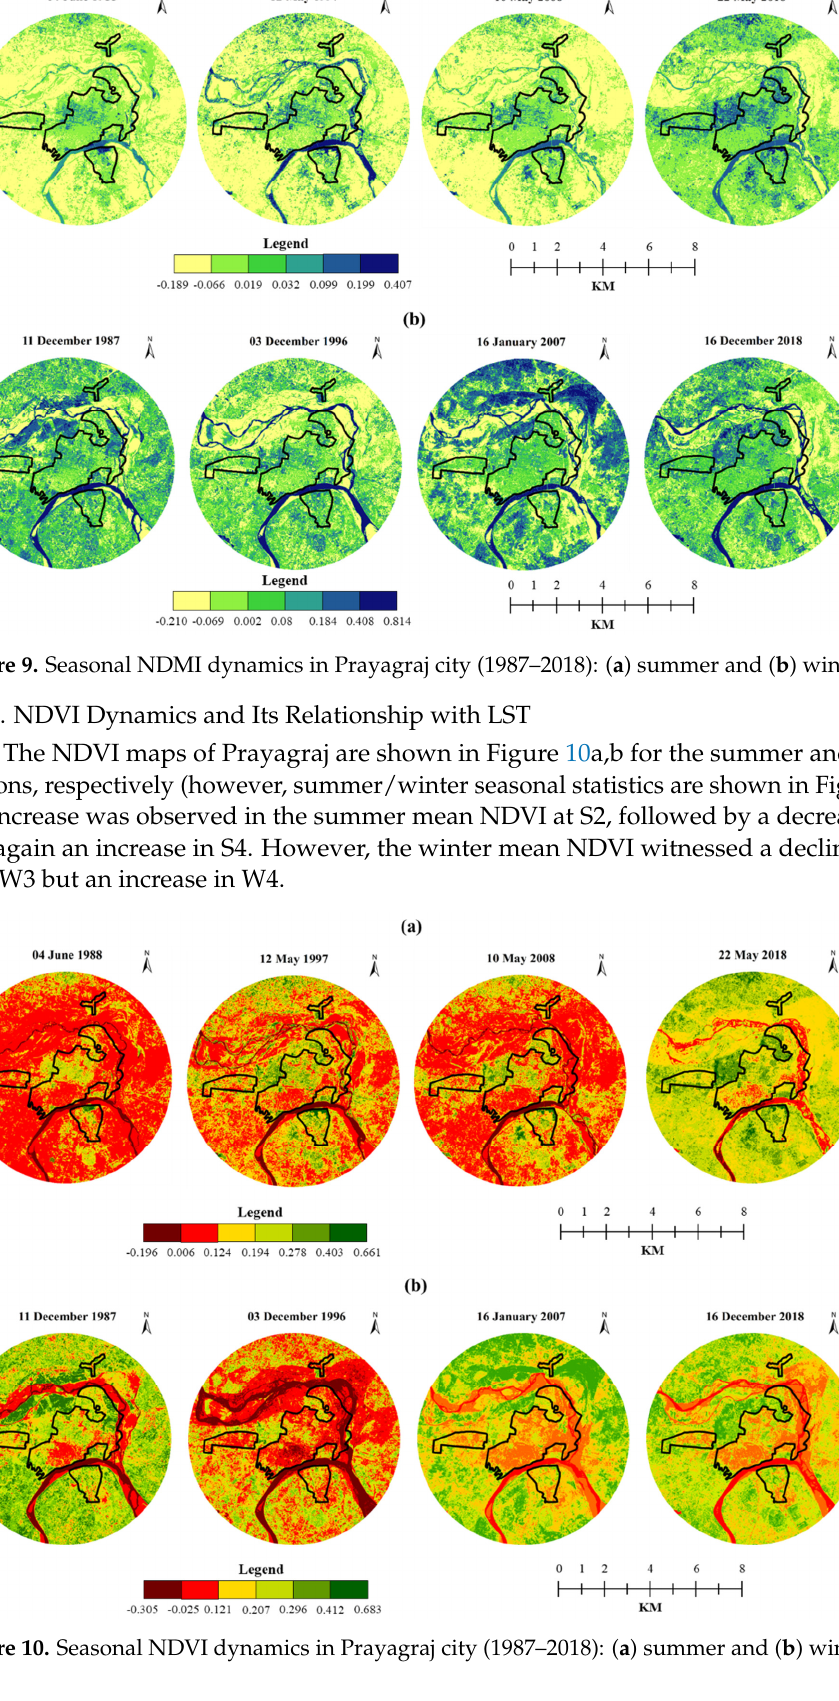
season, but its role was very weak in the winter. 3.3.5. NDWI Dynamics and Its Relationship with LST The NDWI maps of Prayagraj are shown in Figure 11a,b for the summer and winter seasons for all time points, respectively (however, summer/winter seasonal statistics are shown in Figure A1). The summer and winter mean NDWI followed a similar pattern, first declining in S2 and W2, then amplifying in S3 and W3 before again declining in S4 and W4. High-density water bodies were concentrated in the northeast (8–9.5 km) due to the Ganga River flow in S1 and W1. The high-density vegetation was concentrated in the northwest and southeast, which decreased in S2, W2, S3, and W3. Then, high-density veg- etation increased in the northwest and southeast in S4 and W4, respectively. Therefore, it is apparent that the forest and grassland were mainly dominant in the northwest direction from the city center.